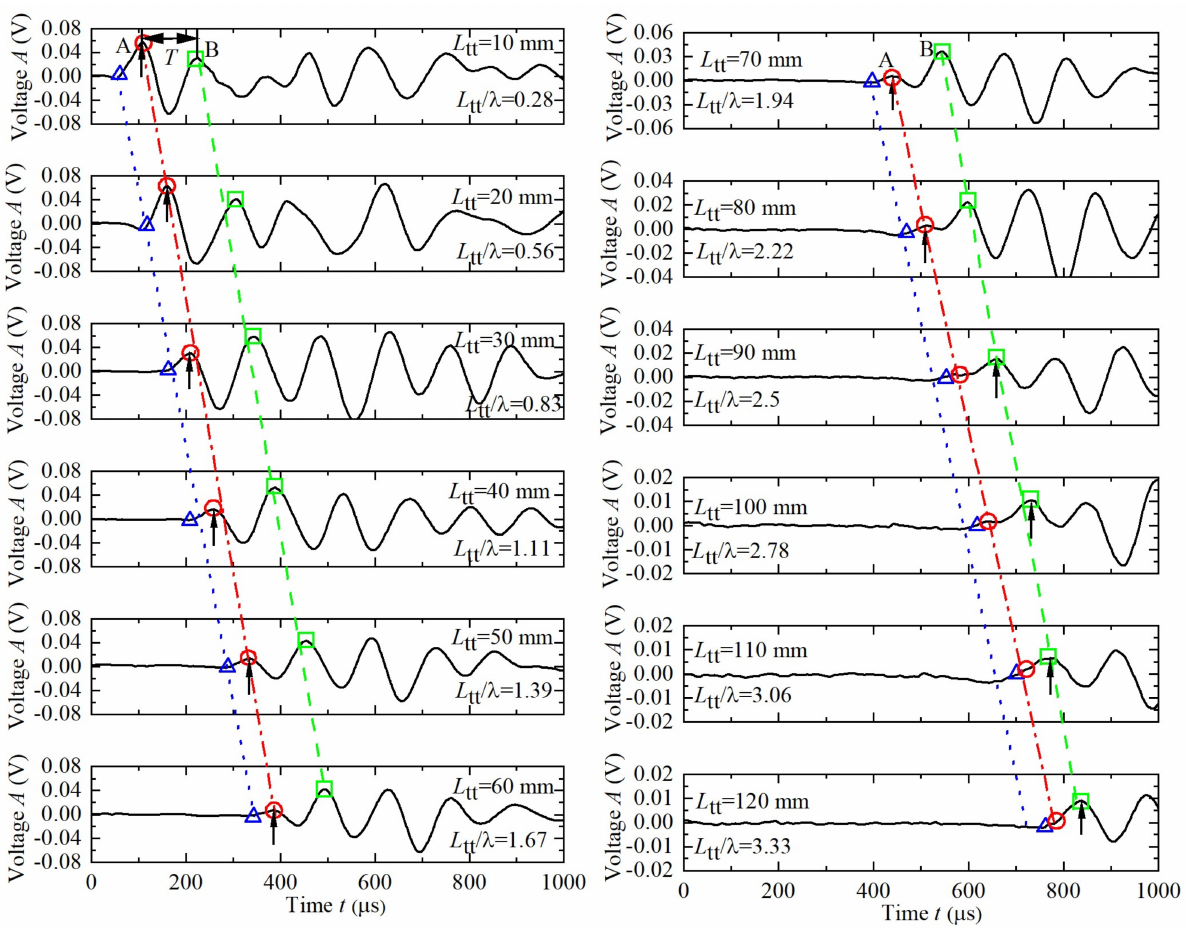
Figure 4. The 12 received waveforms at f = 5 kHz.